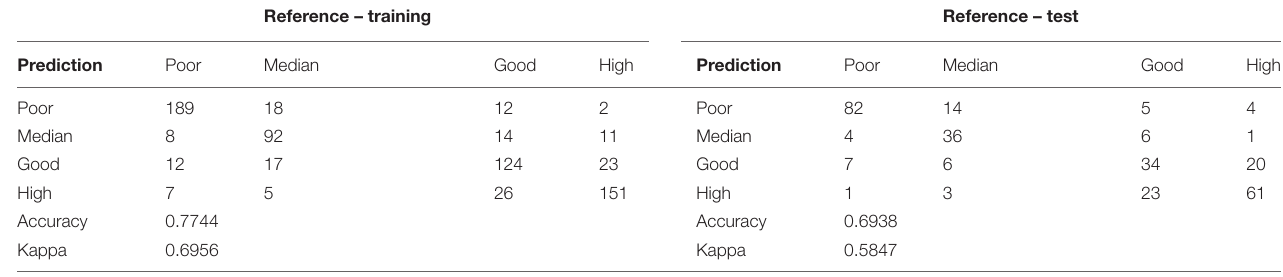
TABLE 7 | Rating Model in RF in 2019.